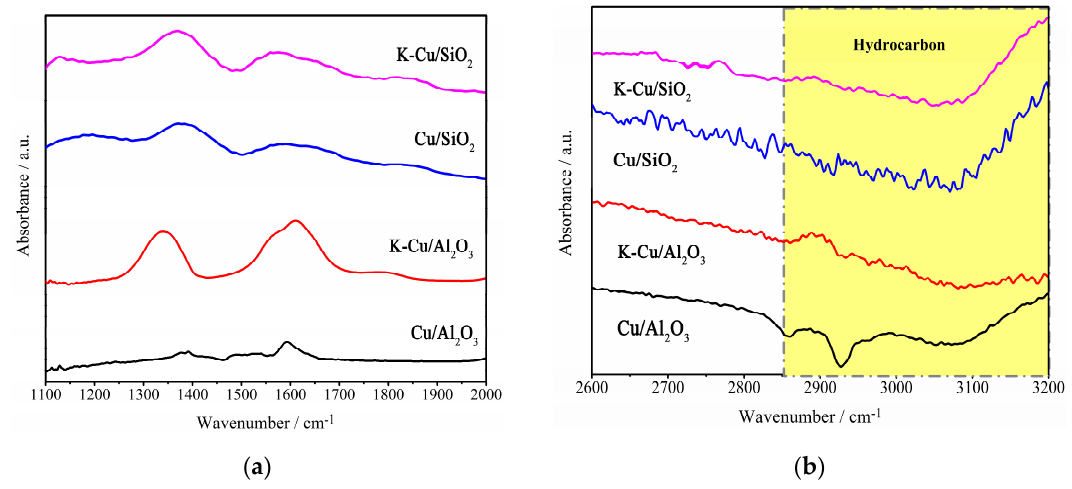
Figure 10. In situ Fourier-transform infrared (FTIR) spectra of CO adsorption over reduced Cu/Al 2 O 3 , K-Cu/Al 2 O 3 and Cu/SiO 2 , K-Cu/SiO 2 catalysts during CO flow at 400 °C for 30 min and then under Ar at 400 °C for 30 min.